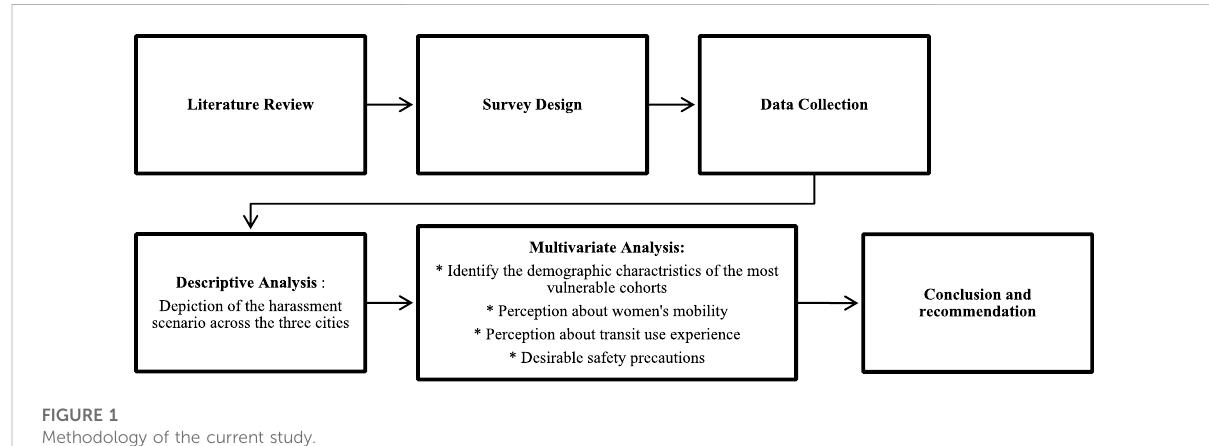
FIGURE 1 Methodology of the current